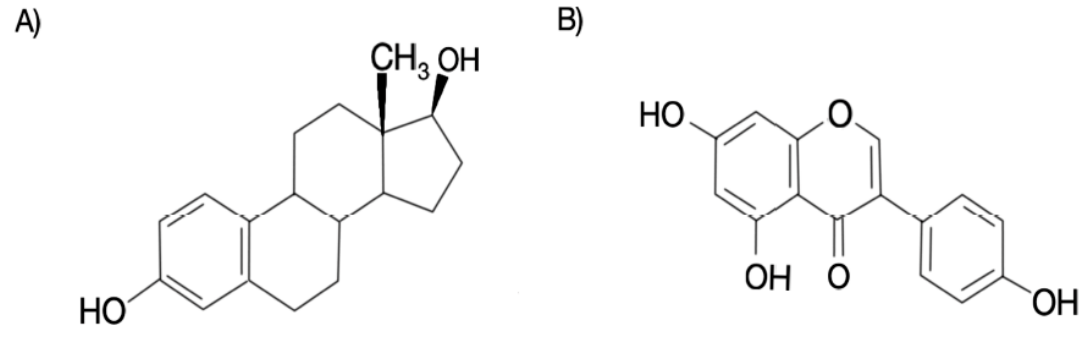
Figure 1. Chemical structures of 17 β -estradiol ( A ) and genistein ( B ).